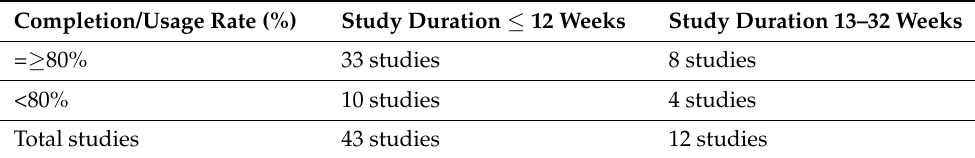
Table 3. Distribution of studies based on mobile app usage rate and